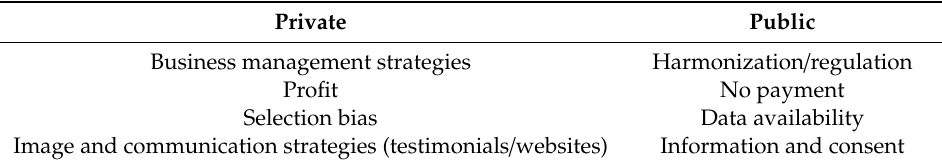
Table 1. Faults and strengths of public and private biobanks in